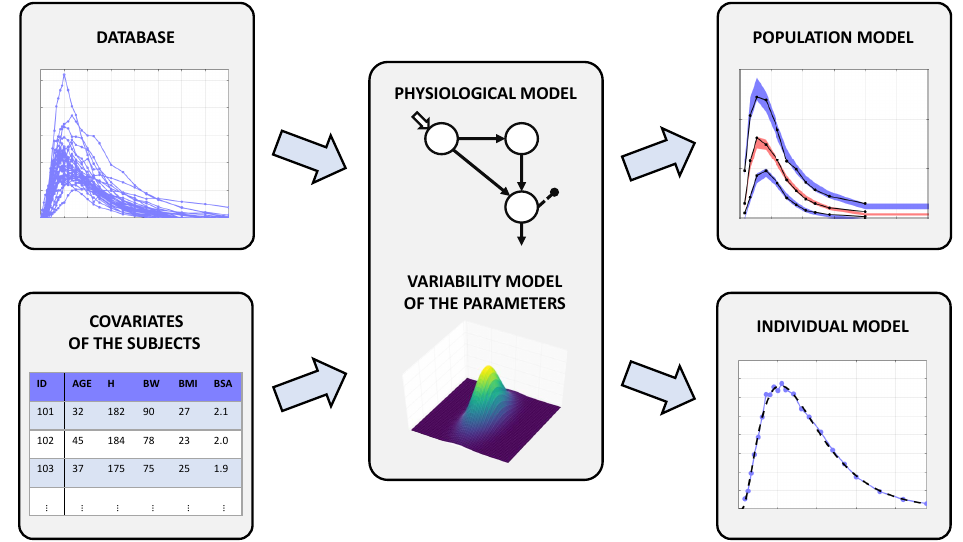
Figure 2. Schematic representation of the NLME approach. The central panel represents an NLME model: it consists of a structural model of the system coupled with a model of the parameter variability. Feeding the NLME model with a large database containing also subject covariates, one can obtain both the population and the individual models better fitting the